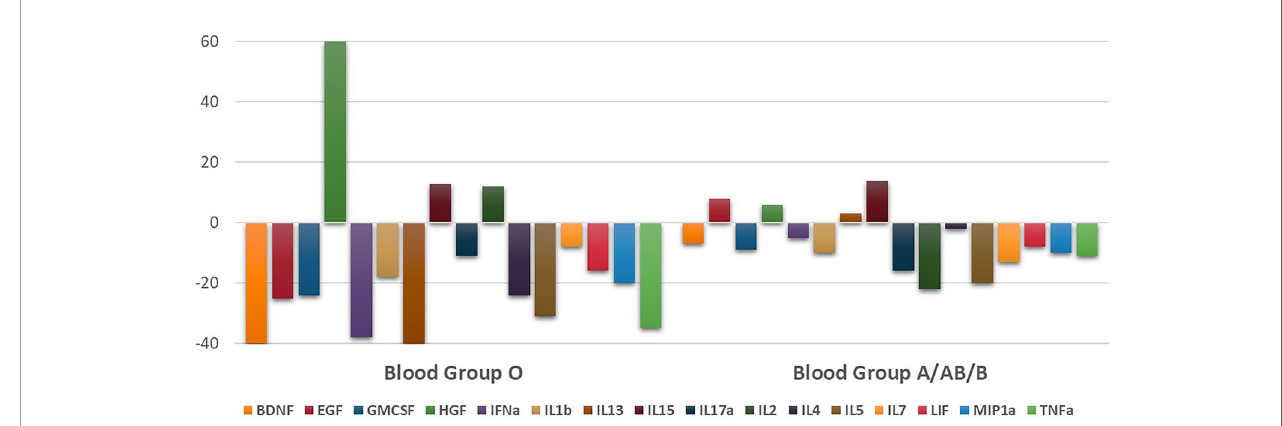
FIGURE 3 | Evolution of the level of cytokines represented by the percentage change of each one after 6 days of hospital admission.